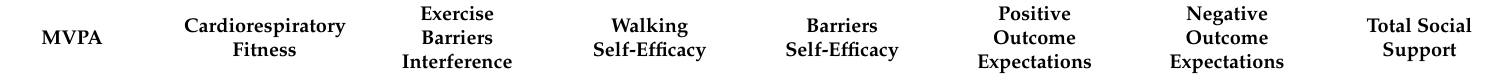
Table 4. Pearson correlation matrix for BMI, moderate-to-vigorous PA, cardiorespiratory fitness, and SCT variables.